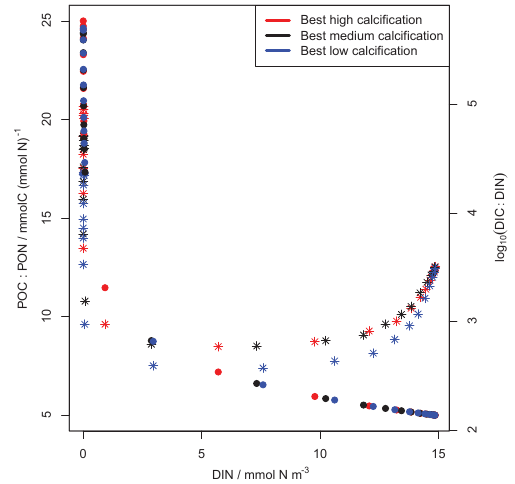
Figure 11. Ratios of [POC]:[PON] and [DIC]:[DIN] determined from daily sampled noon values of model results. Filled cir- cles represent log 10 (DIC:DIN) ratios. Asterisk symbols represent POC:PON ratio over the duration of the